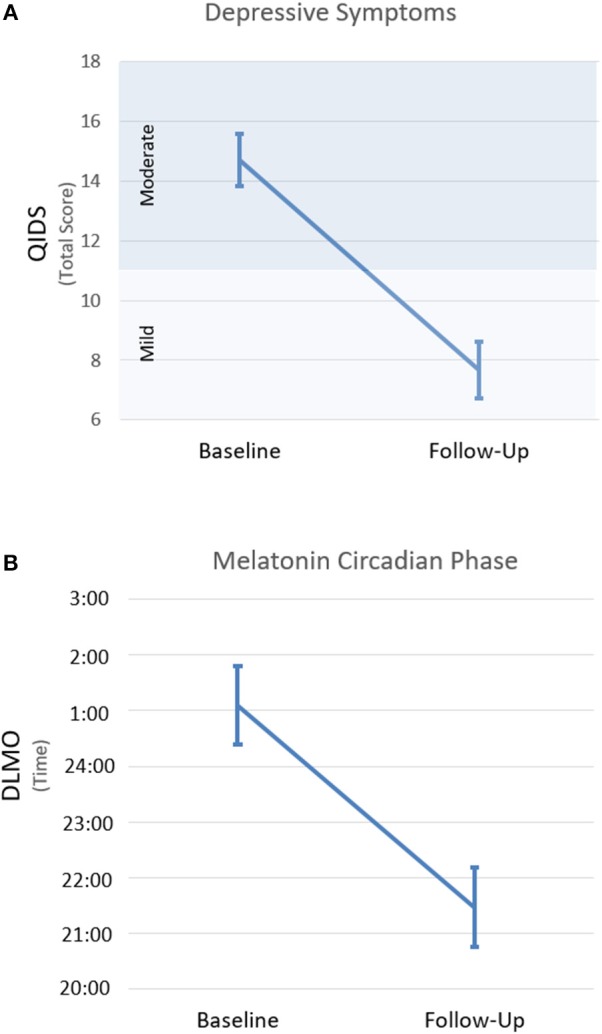
Changes along the course of intervention for depression severity (A) and the timing of dim light melatonin onset (B). Changes from baseline (i.e., before intervention start) to follow-up (i.e., after 8 weeks of intervention). Error bars indicate SEM. QIDS, quick inventory of depressive symptoms; DLMO, dim light melatonin onset.